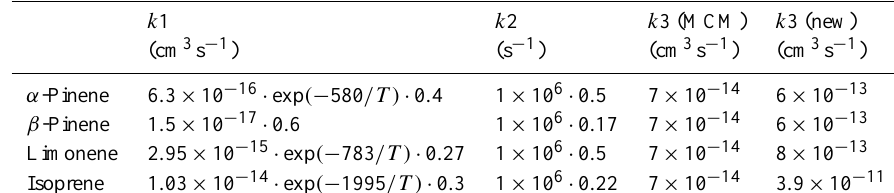
Table 1. Reaction rates for the most crucial chemical equations presented under Eqs. (1)–(4).